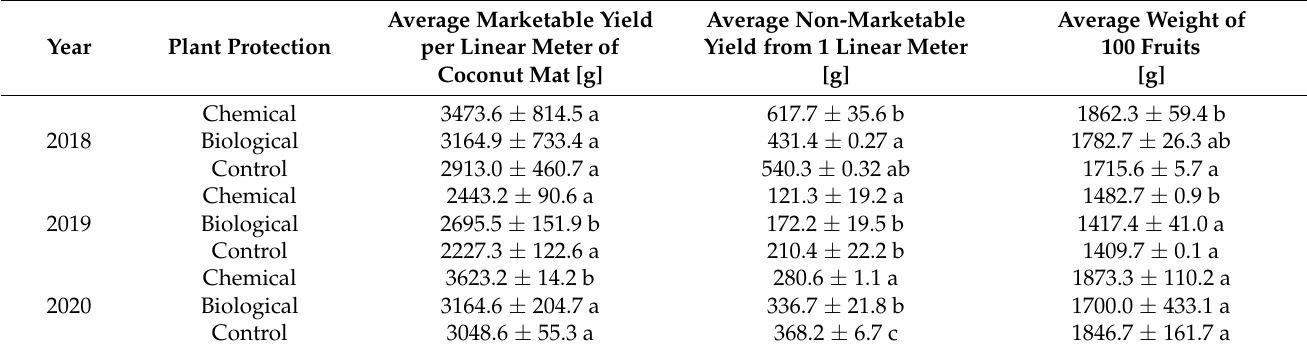
Table 2. Fruit yield of ‘Albion’ directly after harvest.